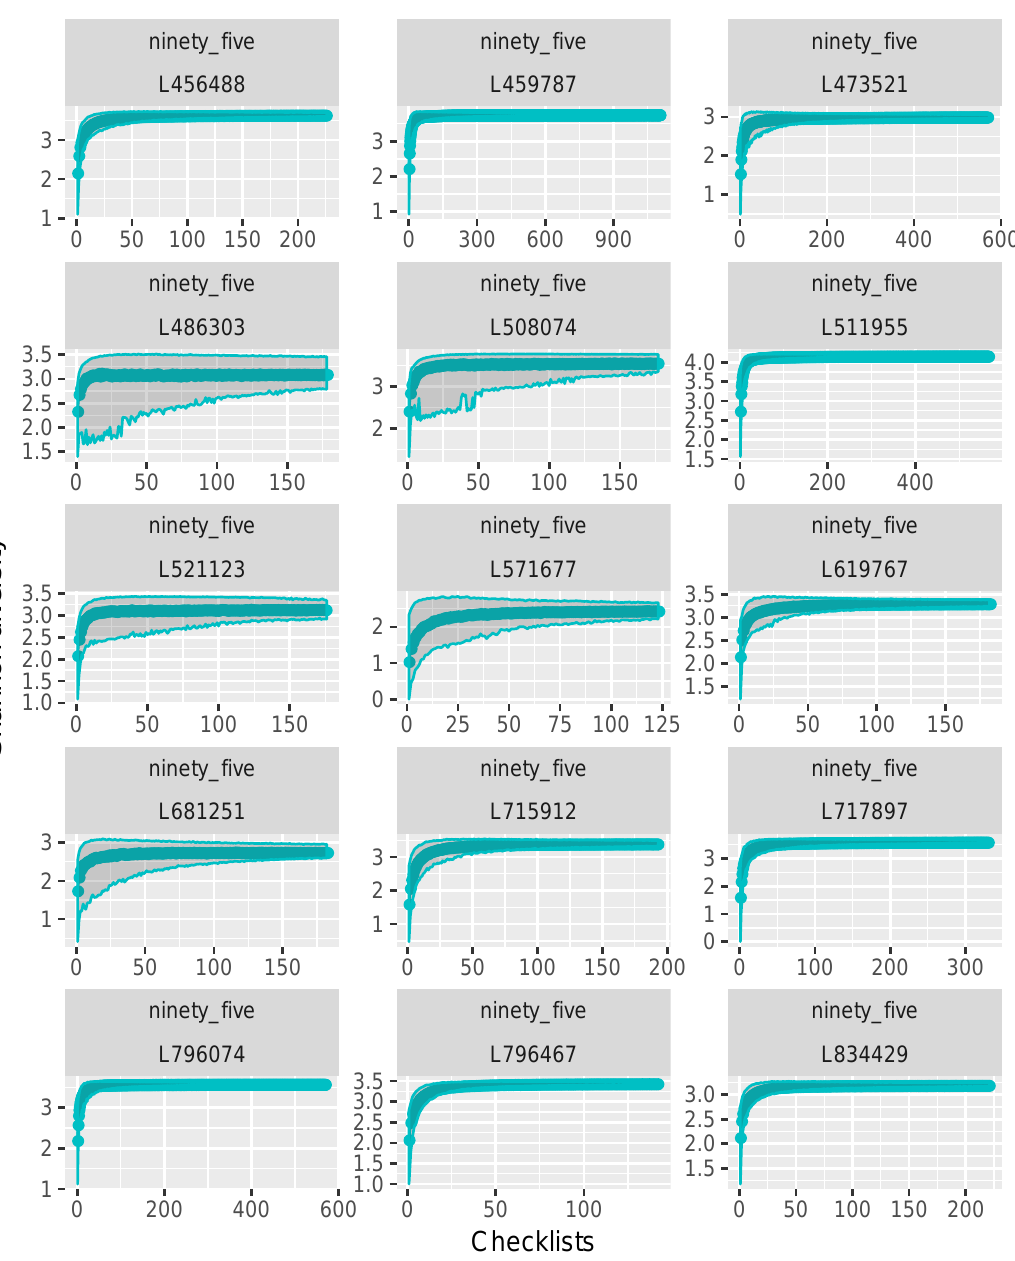
Figure. A4.2. Species diversity accumulation curves for each of 30 North American greenspaces, presented for both